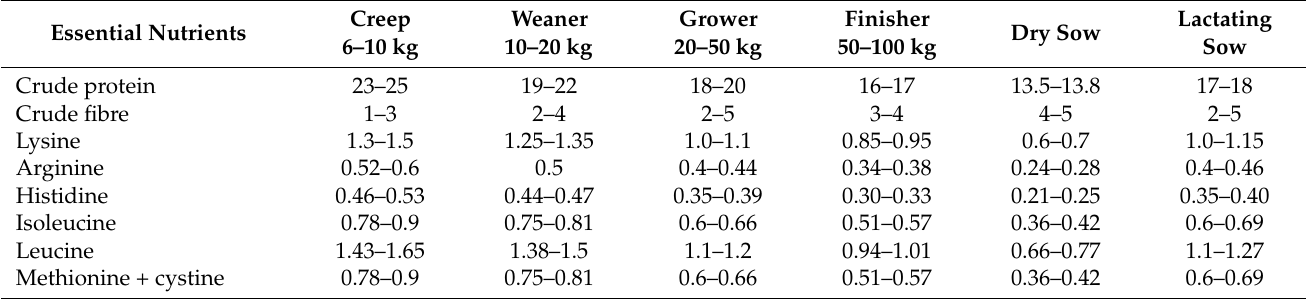
Table 3. Nutrient requirements for pigs at different stages of life